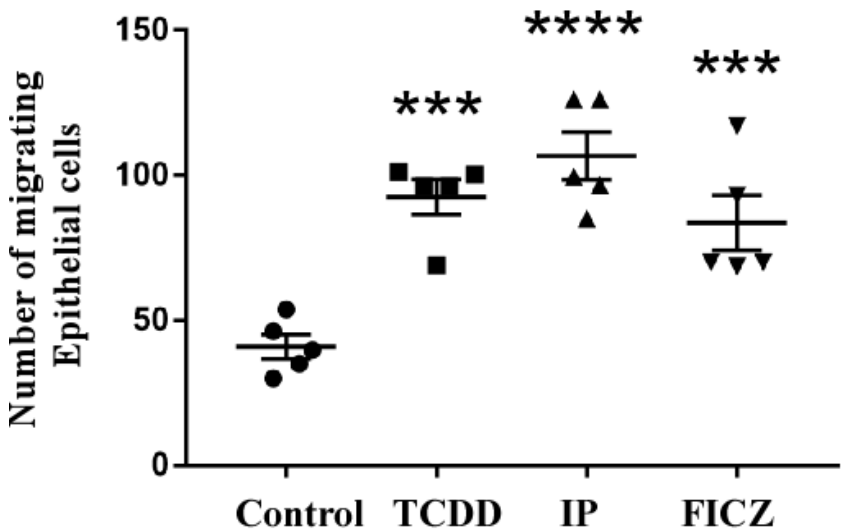
Figure 4. Migration of epithelial cells. In serum-free DMEM/F12 medium that contained TCDD (10 −8 M), IP (10 −7 M), FICZ (10 −7 M ) , MLE-12 cells were cultured for 24 h. Images were taken after 24 h. Crystal violet-stained cells took on a purple hue. The quantification of cells was performed as described above. The number of migrating cells was totaled and presented as folds of increase compared to control cells. Five independent experimental means ± SEM are represented in the